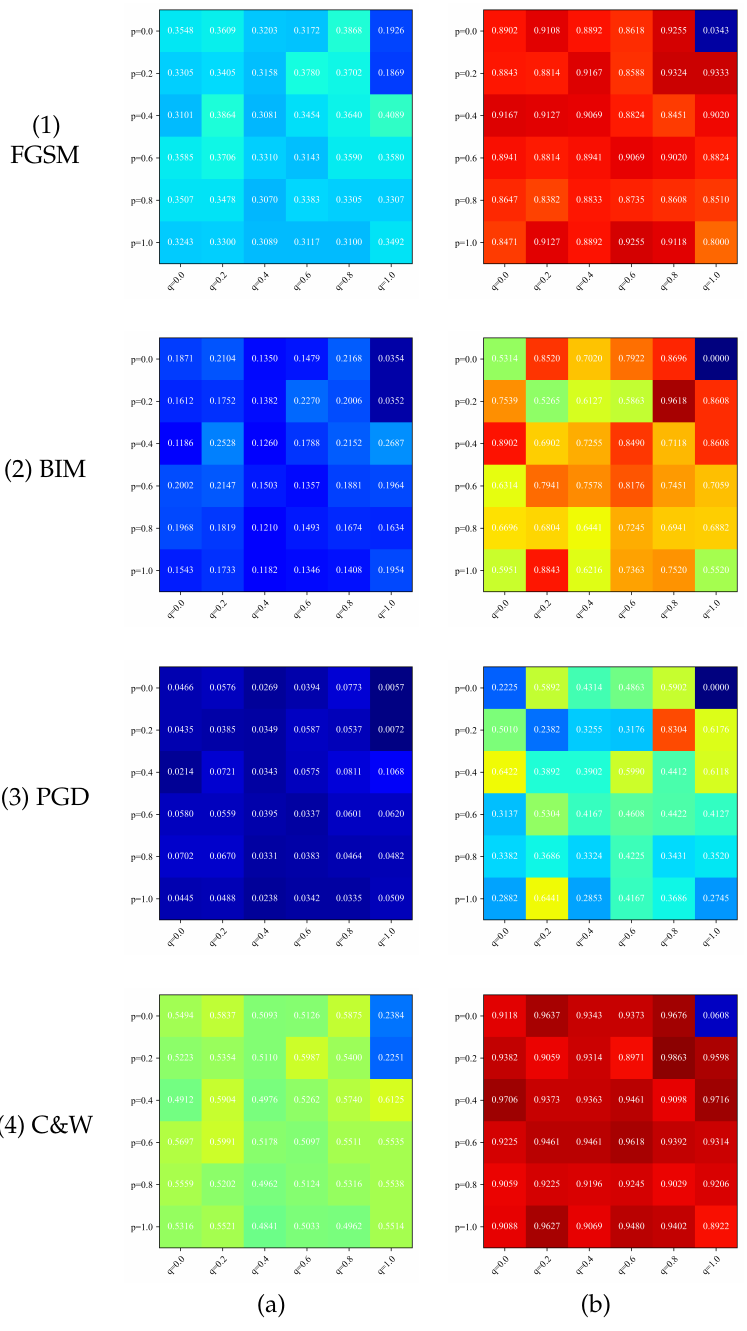
Figure 4. Heat map of the accuracy of the model against the adversarial examples attack with different values of p and q . ( a ) Birds. ( b )